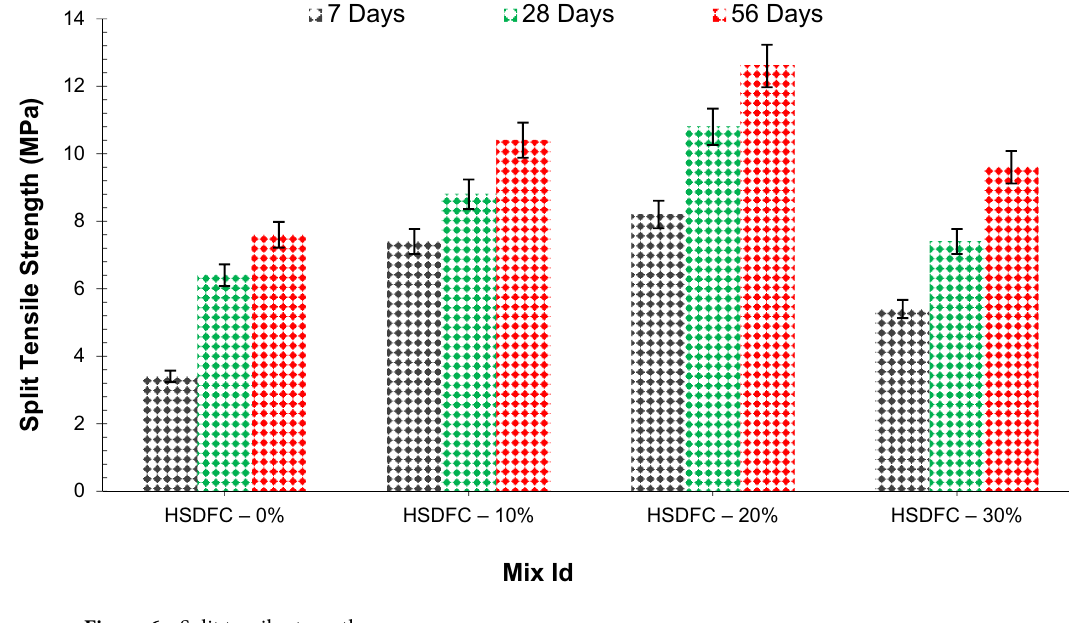
Figure 6. Split tensile strength.